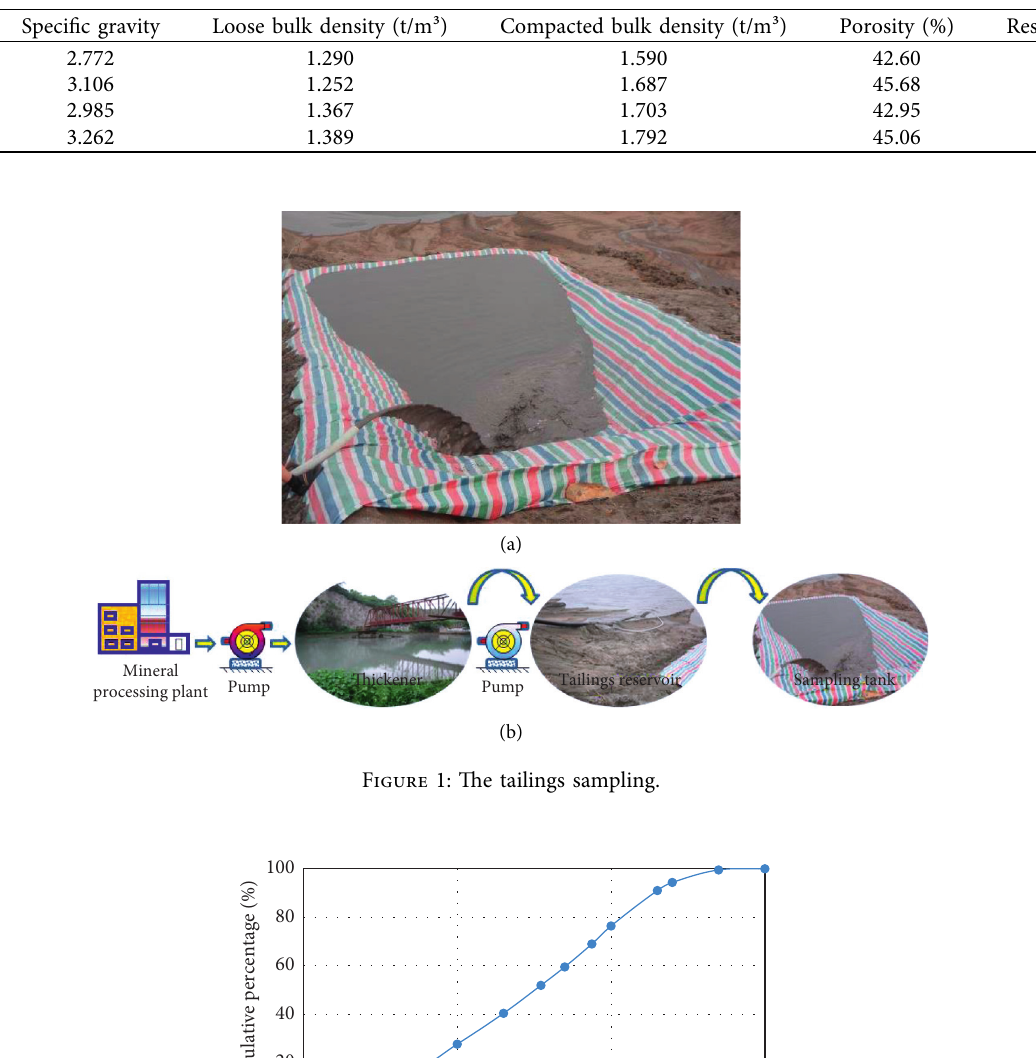
Table 1: Physical properties of the backfill material.